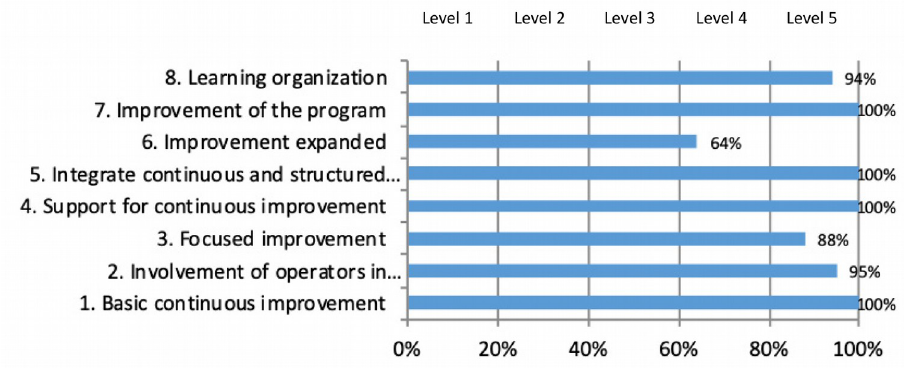
Figure 6. Maturity level in